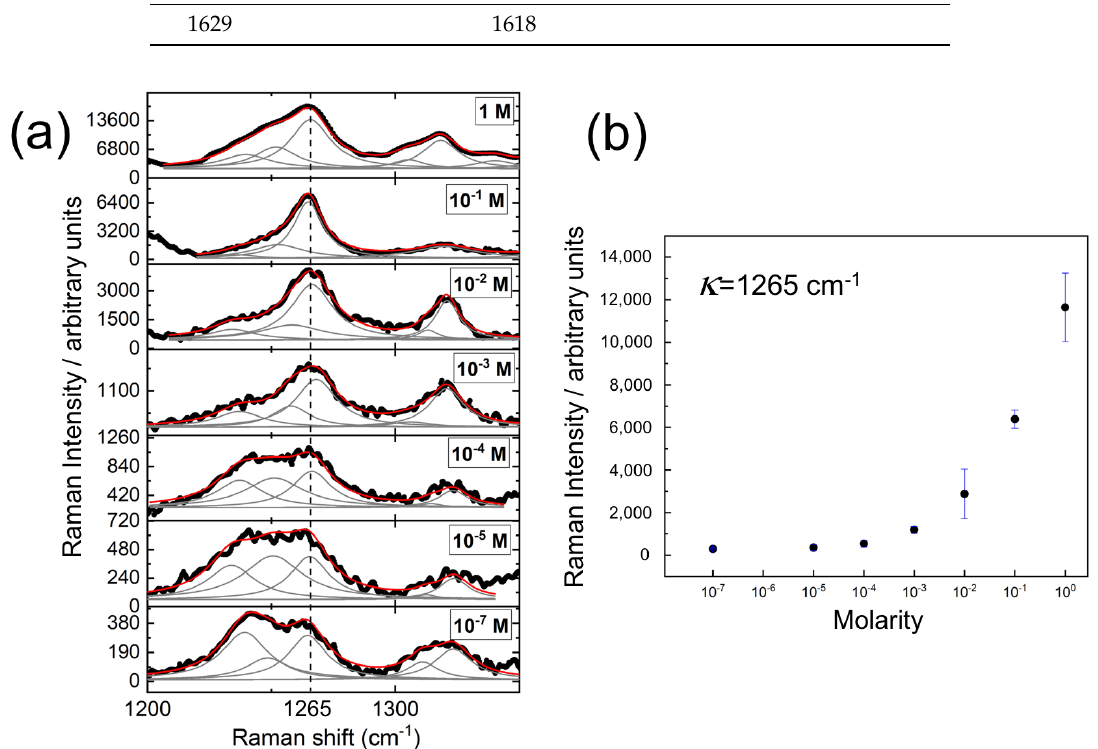
Figure 5. ( a ) Detail of the Raman spectra around κ = 1265 cm − 1 (represented as a dashed vertical line). The gray lines under the curve correspond with the Lorentzian lineshapes obtanied after fitting. The red line represents the results obtained from this decomposition. This fitting has been done for several molarity values from 1 M to 10 − 7 M. The case of M = 10 − 6 has not been prepared nor measured. ( b ) Relative intensity of the κ = 1265 cm − 1 Lorentzian peak as a function of molarity. The error bars represent the variability between samples.